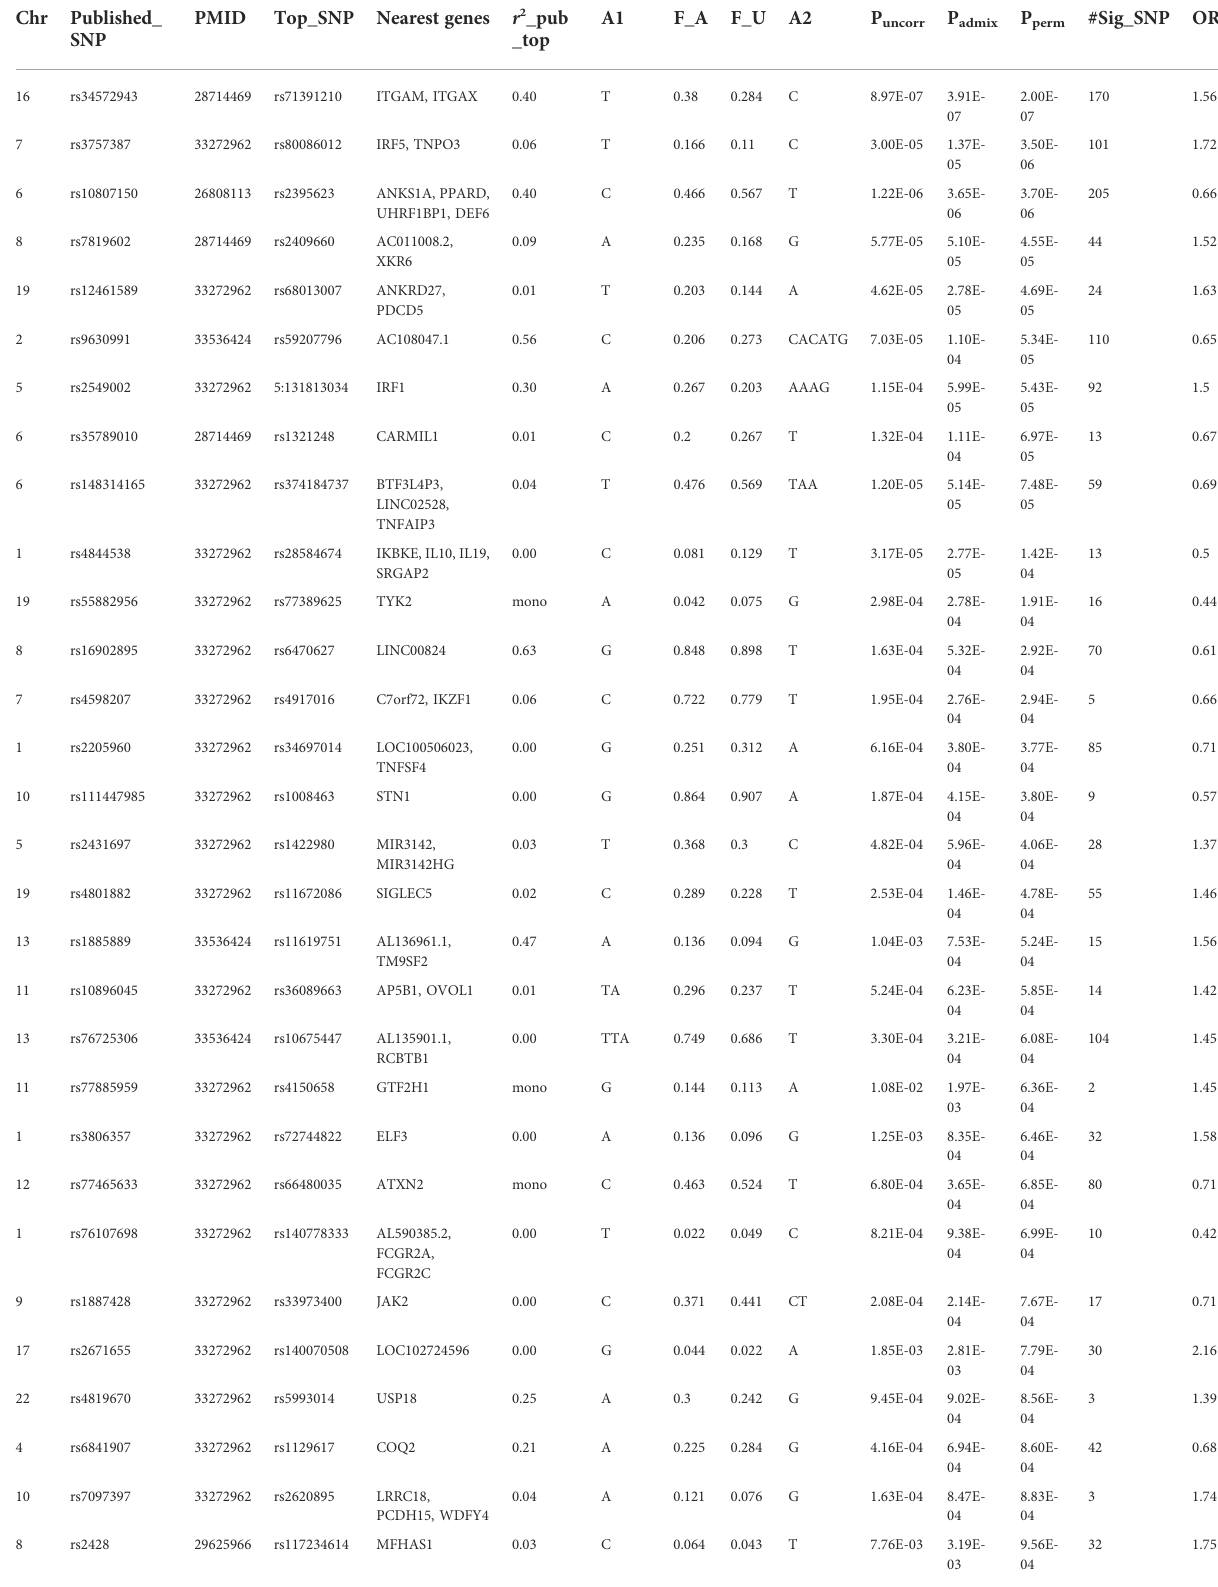
TABLE 2 Replication of 97 published loci at P perm <